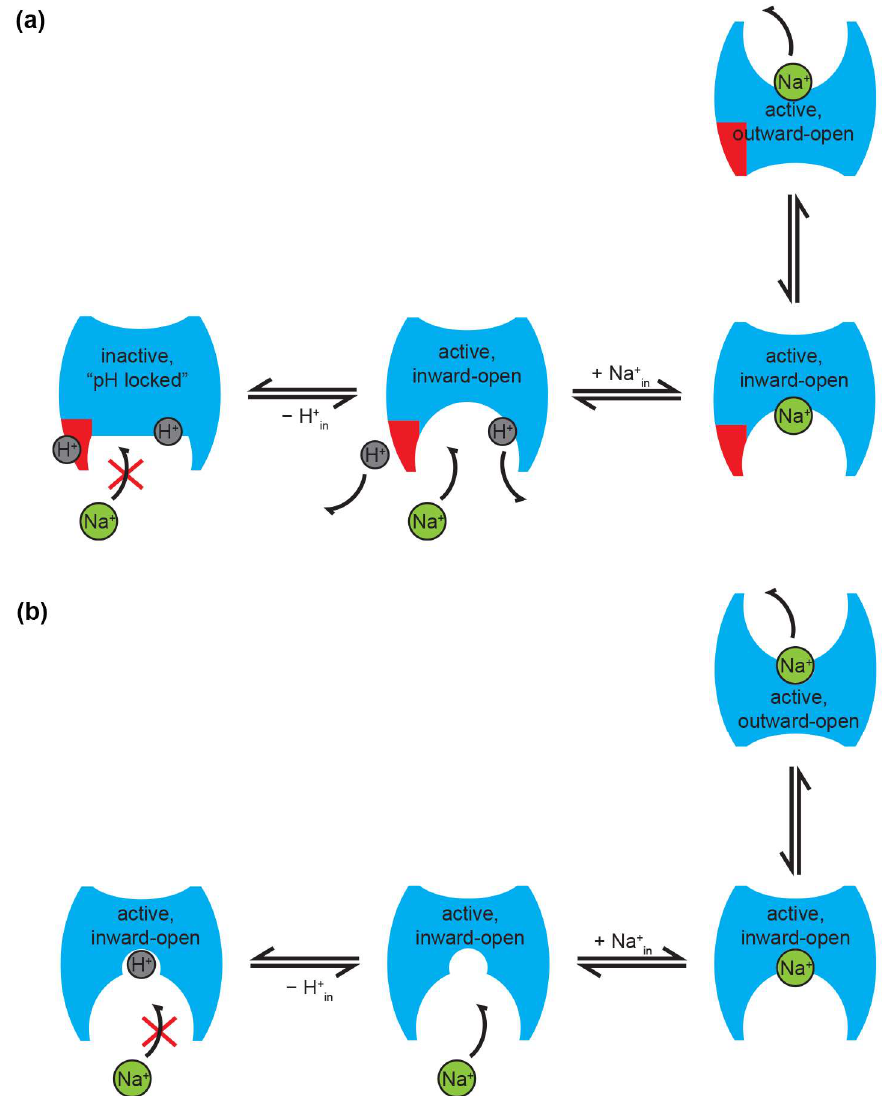
Figure 3. Proposed modes of pH regulation of Na + /H + exchanger activity. ( a ) In the pH sensor model, an acidic cytoplasmic pH locks the protein in an inactive form. The pH sensor region (shown in red) is protonated at acidic pH, preventing Na + from accessing the binding site. At alkaline pH, the pH sensor is deprotonated, allowing Na + binding, followed by translocation across the membrane. Note that an additional H + is also shown bound to the substrate binding site(s) of the transporter. In order to ensure correct coupling, this has to be released before Na + can be translocated. ( b ) In the competition model, both substrates compete for the same binding site; thus, activity is down-regulated at low pH, due to H + outcompeting Na + for binding to the exchanger. Note that, in this model, all forms are active at all times, and are, thus, capable of performing transport in the presence of substrate. In both panels, the notations “in” and “out” refer to cytoplasmic and periplasmic, respectively. The figure shows schematic transport for a 1:1 H + :Na + stoichiometry, but is equally valid for other stoichiometries, such as 2:1 for EcNhaA. The red cross in both panels shows that under the conditions depicted Na + cannot bind to the exchanger. For simplicity, in both panels, only half of the transport cycle (Na + binding and translocation across the membrane) is shown. A schematic of the full transport cycle in the competition mechanism can be found in [71].